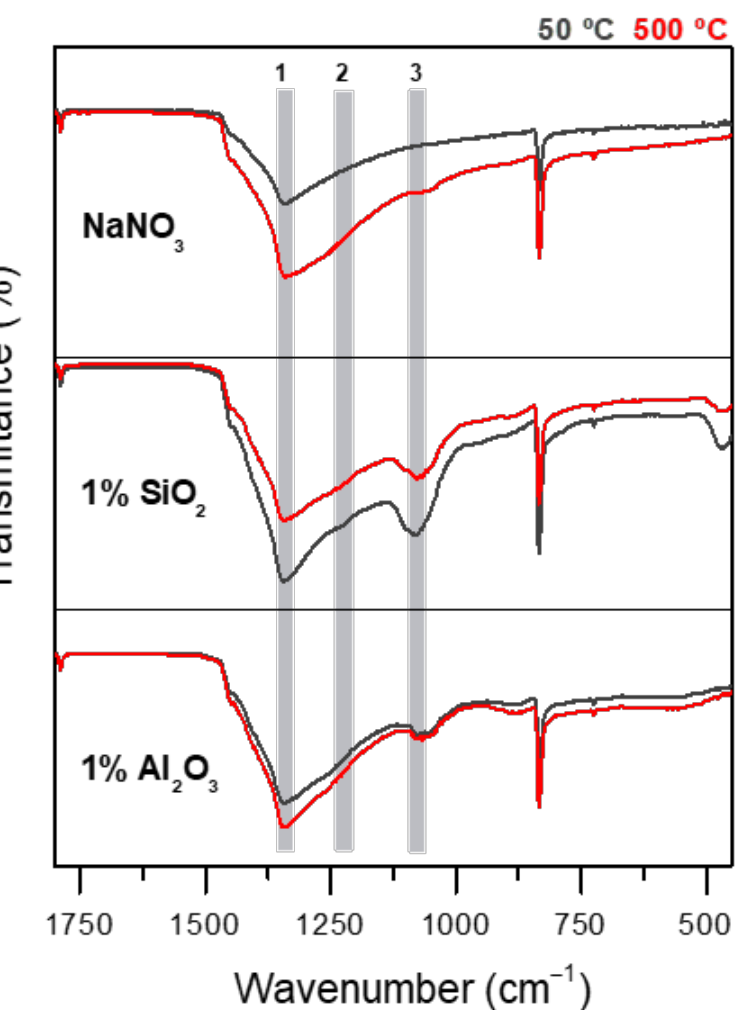
Figure 6. FT-IR spectra of NaNO 3 and NaNO 3 /SiO 2 , NaNO 3 /Al 2 O 3 NFs with 1% wt. of NPs after thermal treatment at 50 °C and 500 °C. Band (1) corresponds to asymmetric stretching mode of NO 3− , and bands (2) – (3) corresponds to fundamental vibration bands of NO 2− .